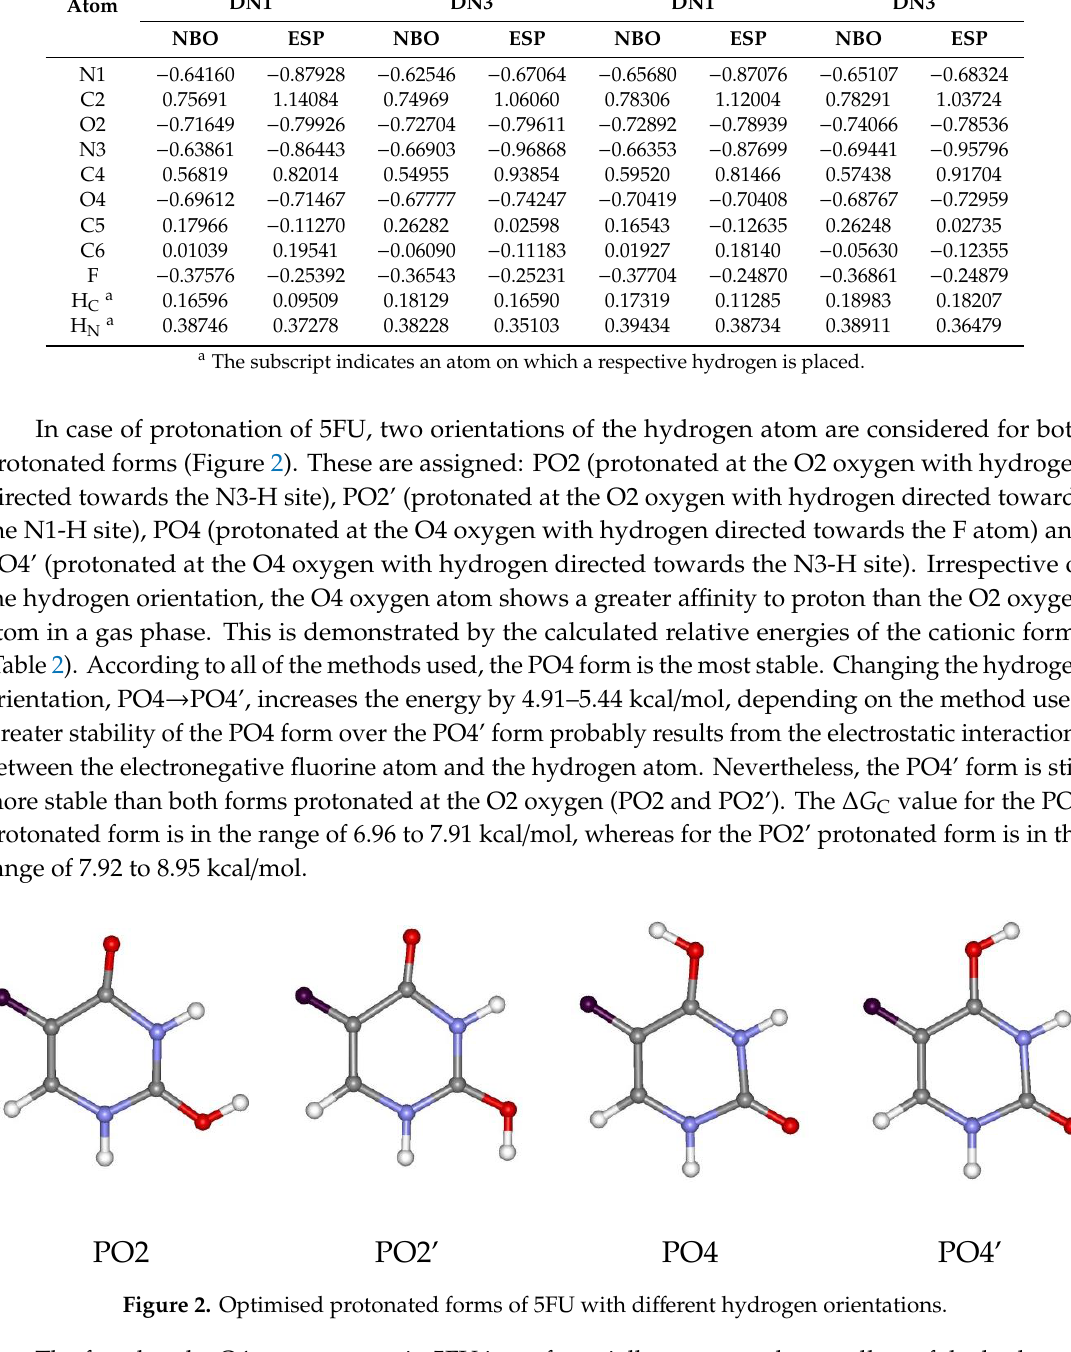
Table 4. The charge distribution in PO2 and PO4 cations from NBO and ESP analyses. A t o m